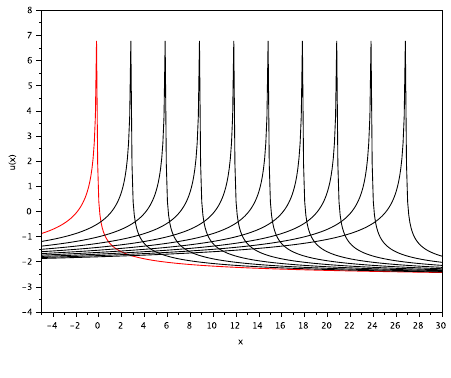
Fig. 5. The solution given by (33) plotted at t = (0 , 10) . The first curve is at t = 0 . As seen by the black curves, the velocity front travels like a wave as time